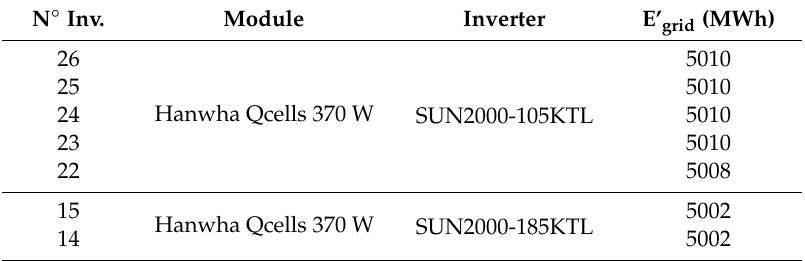
Table 2. Top module / string inverter combinations leading to the higher sub-array grid injected energy; di ff erent number of inverters per sub-array. N ◦